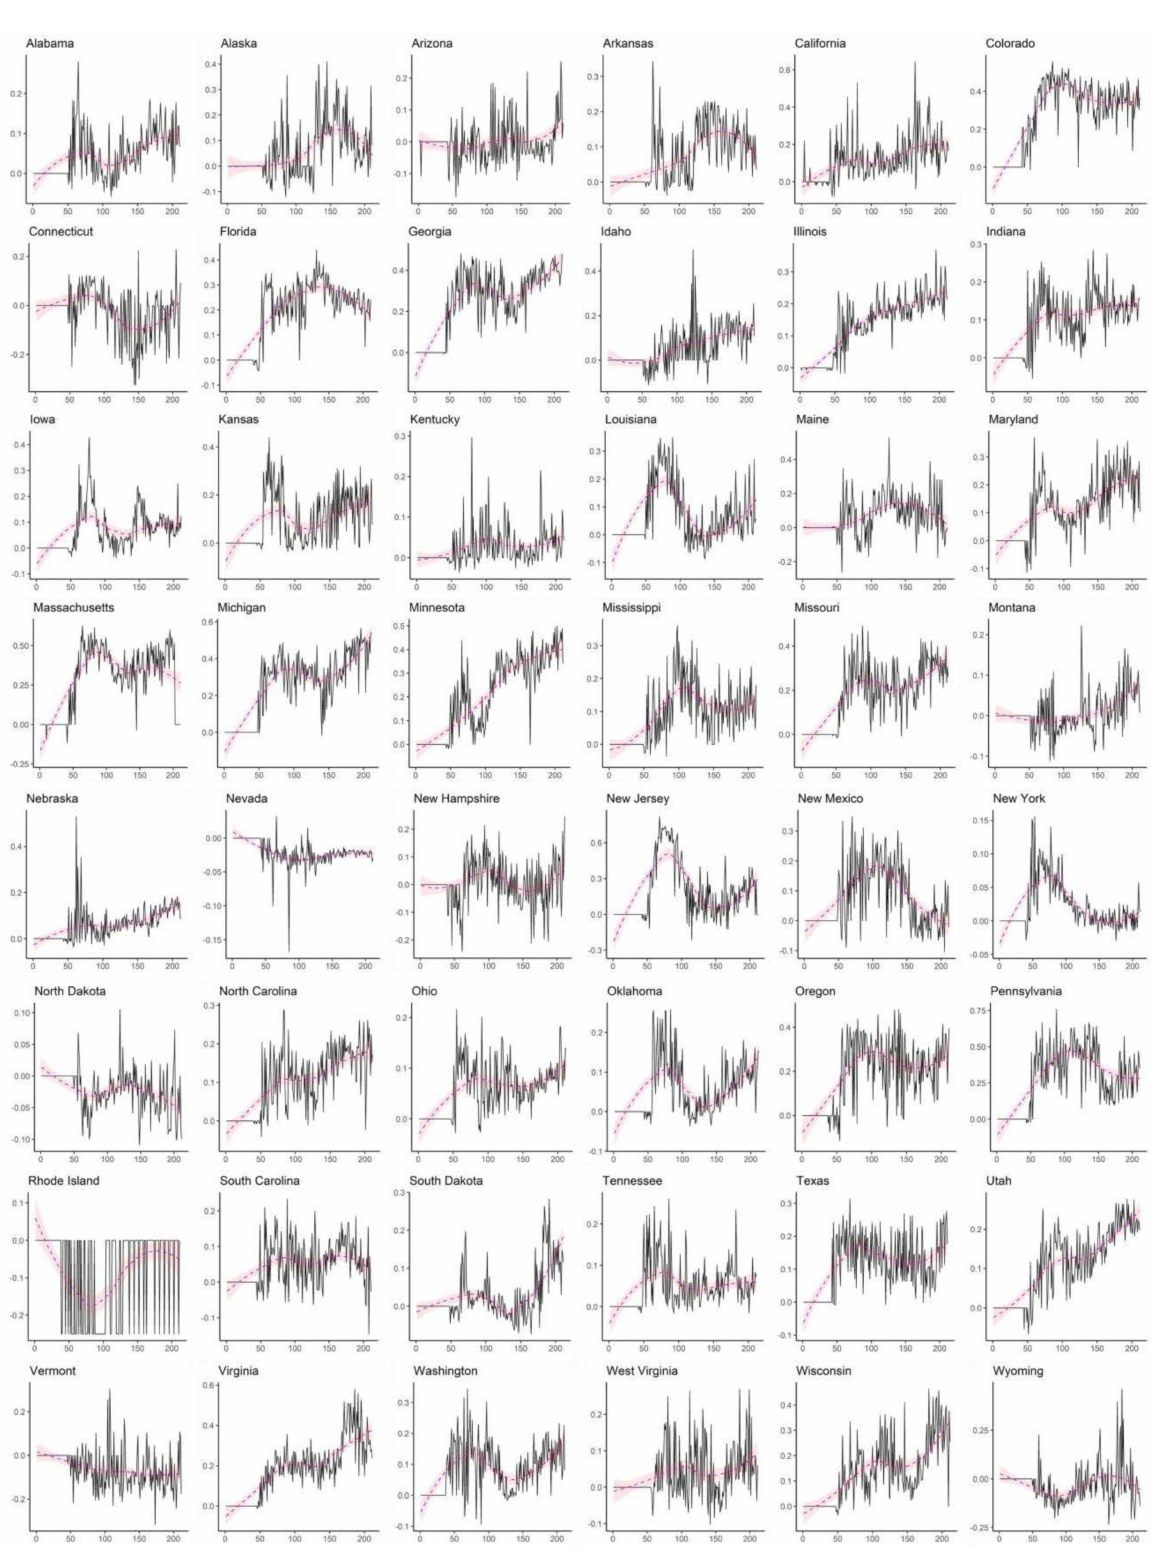
Figure 2. Time series of the Moran’s I index of each state in the United States. The x -axis and y -axis indicate the time in days and Moran’s I value, correspondingly, and the red curve represents the fitted value with a 95% confidence interval. Obvious changes from around the 50th day can be observed, displaying several patterns of temporal changes in spatial effects, such as a reversed U-shape or N-shape. There were zero values in the numbers of daily new infections for Rhode Island, which caused the Moran’s I curve to swing back and forth from 0 to negative